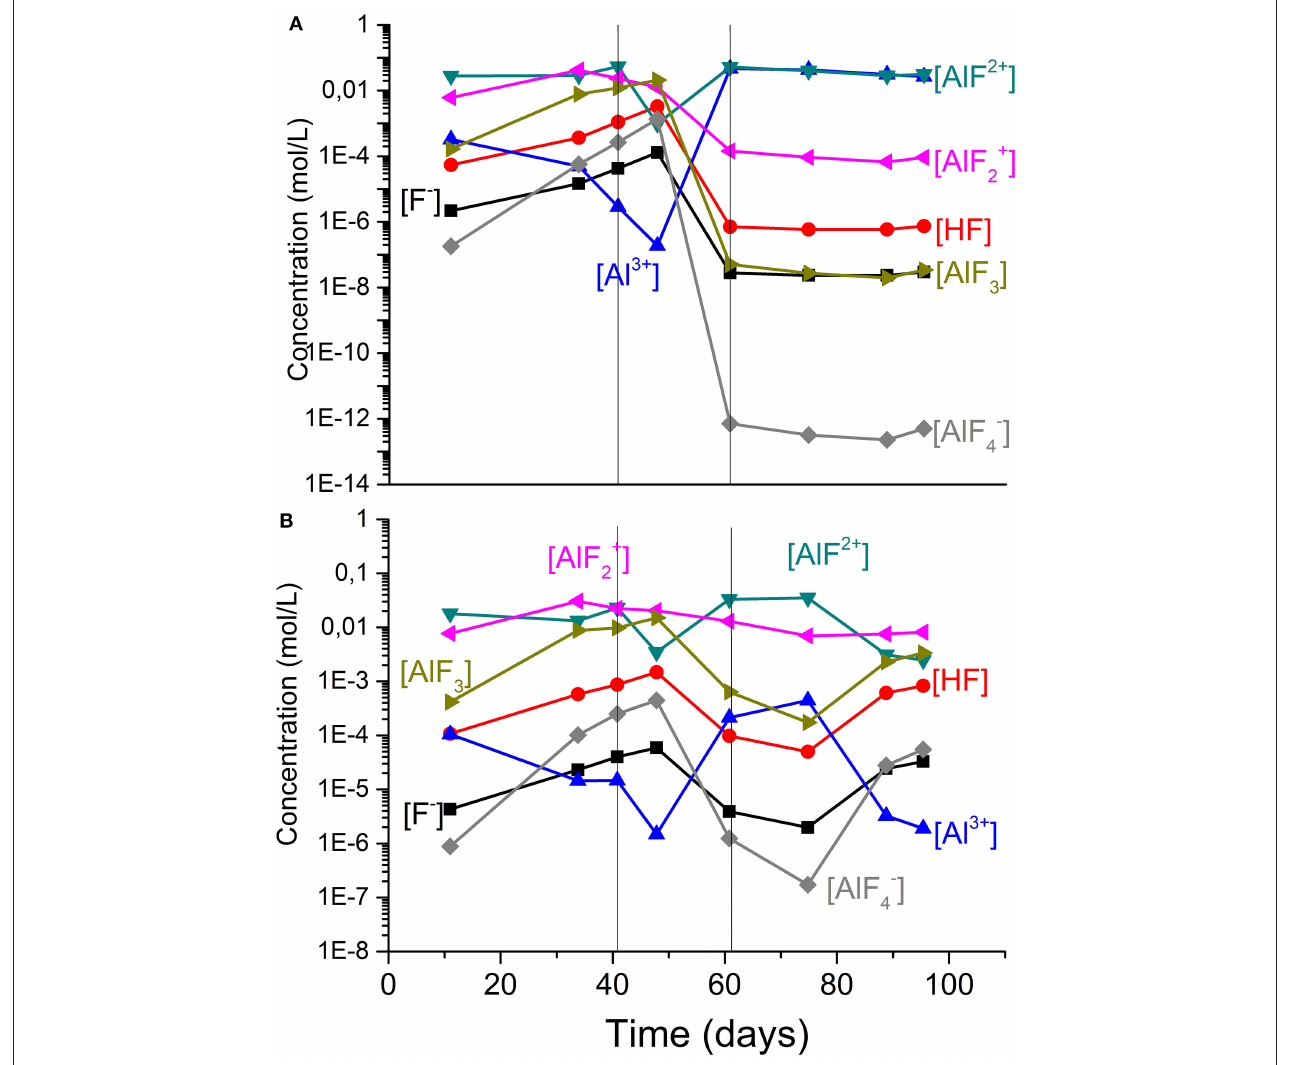
FIGURE 4 | Estimated aluminium speciation in the presence of fluoride ions for high-grade ore (HG) for (A) the reference (C6) and (B) HG No-Al (C5) columns. The vertical lines indicate solution bleeding. Experiments with S. thermosulfidooxidans growing in Norris growth medium supplemented with yeast extract (0.1 g/L) and amended with 1.0 g/L Al 3 + ; at 50 ± 1 ◦